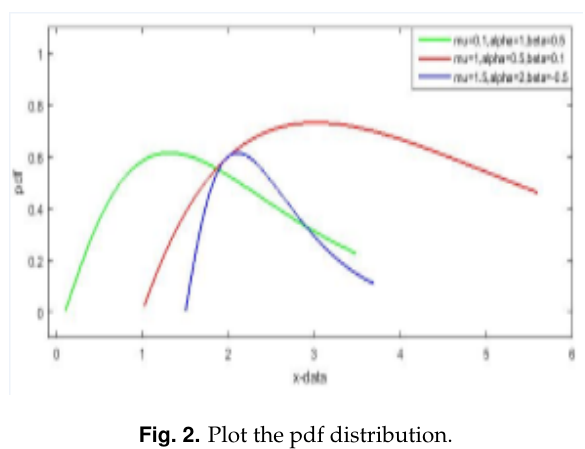
Fig. 2. Plot the pdf distribution.